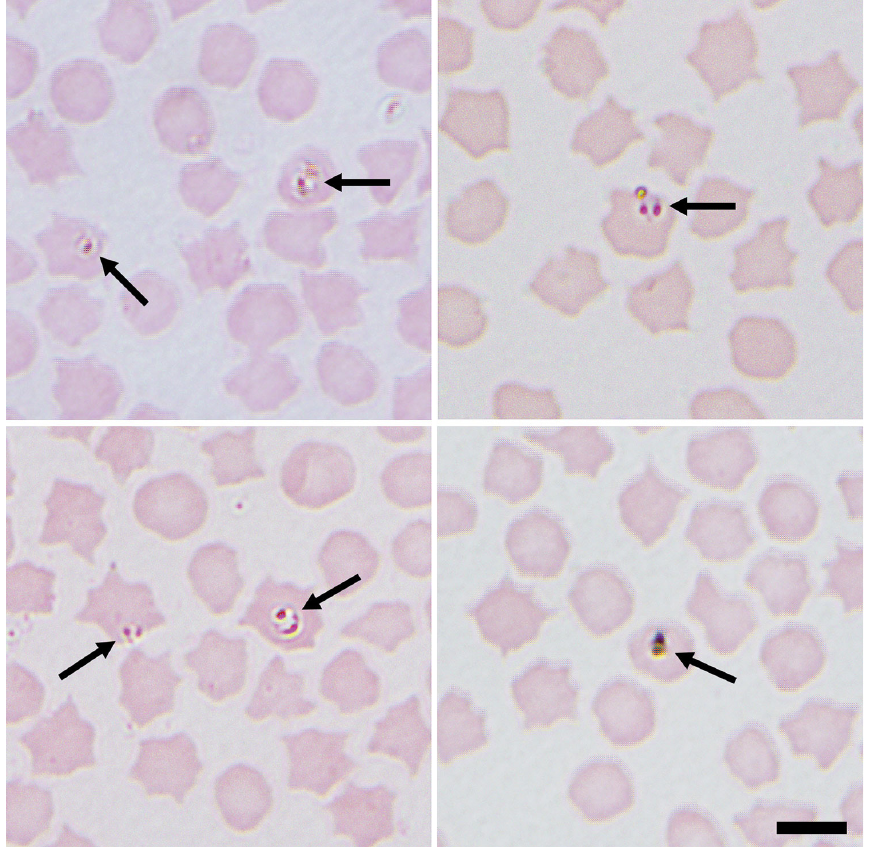
Figure 1. Representative images of small intracellular Babesia (arrows) identified in sheep erythrocytes from several sites in northeastern Scotland, UK. Both paired proforms and ring forms are visible. Images were taken at ×1000 magnification with oil immersion. Scale bar indicates 5 μ m [60].